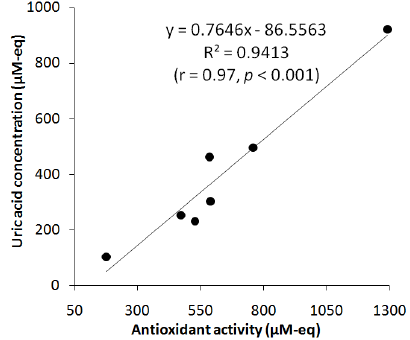
Figure 7. Correlation between salivary UA and